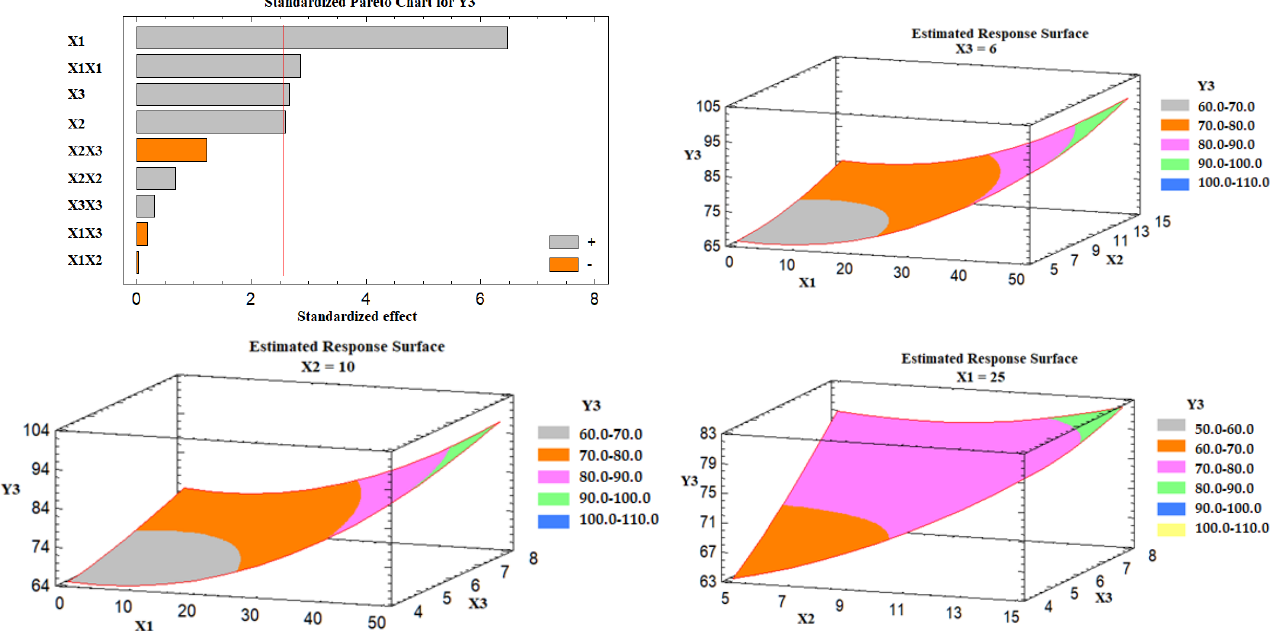
Figure 6. Pareto chart and estimated response surface plots for the effect of the studied factors on the drug release (Y3). Notes: X1; the carrier mixture, X2; the excipient ratio; X3; the percentage of superdisintegrant.